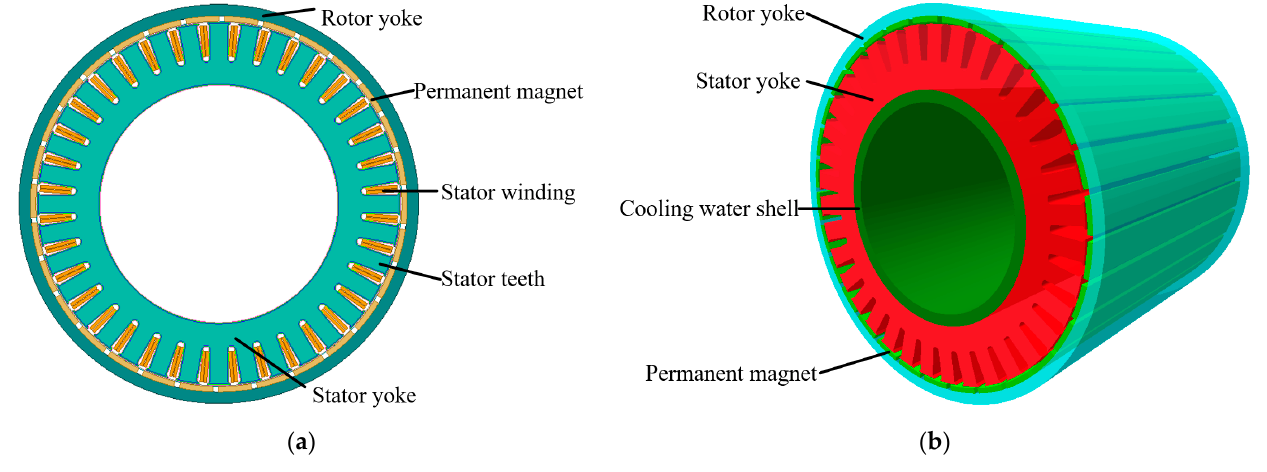
Figure 1. Motor structure: ( a ) planar structure; ( b ) 3D structure. Table 1. The parameters of initial scheme.